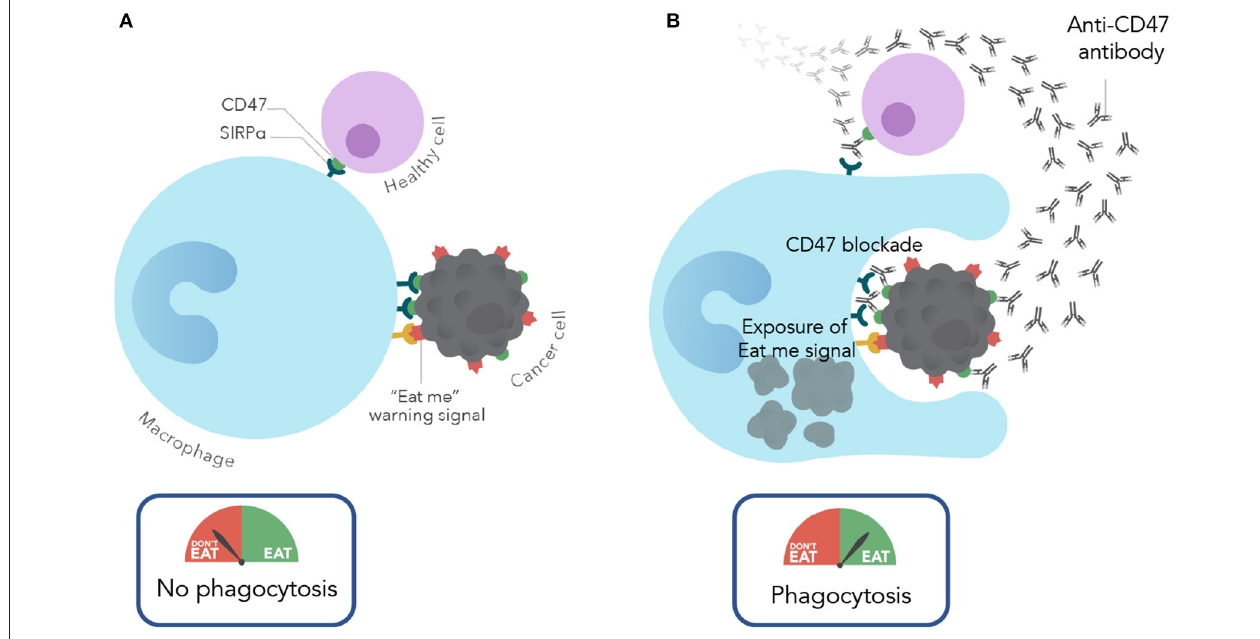
FIGURE 1 | Mechanism of action of CD47 blocking antibodies. (A) Under normal conditions, normal and cancer cells evade macrophage phagocytosis by expressing CD47. In cancer cells CD47 is overexpressed to protect against the expression of eat me/pro-phagocytic signals. (B) With CD47 blockade (with an anti-CD47 antibody), cancer cells are phagocytosed due to CD47 blockade and resulting unmasking of the “eat me” signal. In contrast, normal cells are spared given the lack of expression of pro-phagocytic